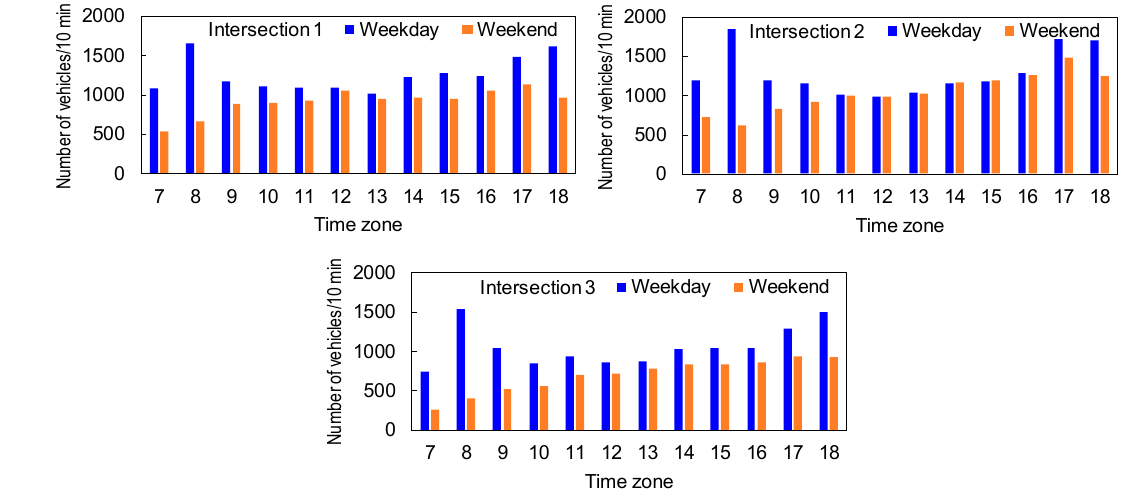
Figure 3. Total traffic volume at each measured hour in each intersection. Table 4. Temporal variation of traffic volume for each type of vehicle.